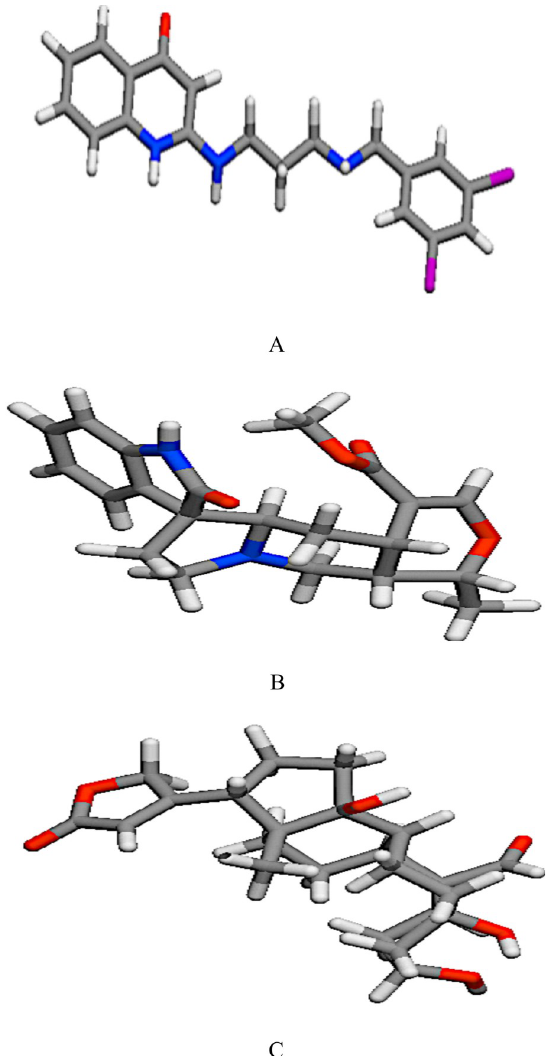
Fig 3. The stick model of the 3D structures of the reference and lead compounds (a) OOU (b) Isopteropodin (c) Strophanthidin. In terms of excretion, Strophanthidin recorded the lowest total clearance (log ml/min/kg), whereas OOU showed the highest. Strophanthidin was not a substrate of renal OCT2, only OOU and Isopteropodin were. All the compounds showed no AMES toxicity, no dermotoxo- city and were non-inhibitors of hERG I proteins. However, only OOU was predicted to be a blocker of hERG II and only strophanthidin was not hepatotoxic. The values for maximum tol- erated dose (log mg/kg/day), oral rat acute toxicity (LD50) (mol/kg) and oral rat chronic toxic- ity (log mg/kg/day) were highest in OOU, Isopteropodin, and strophanthidin respectively. For lead compounds and the reference, the T . Pyriformis toxicity (log g/L) values were all larger than -0.5. Minnow toxicity (log mM) was less than 0.3 only for Isopteropodin (Table 2) Analysis of molecular docking scores Isopteropodin had the lowest binding score with the target protein (Table 3).